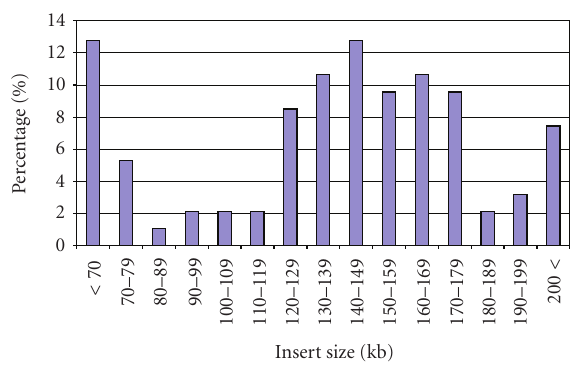
Figure 2: Insert size distribution of Camellia sinensis BAC clones from the CSBCBa library. The average insert size of the BAC library was calculated to be 135kb from an analyzed random sample size of 576 BAC